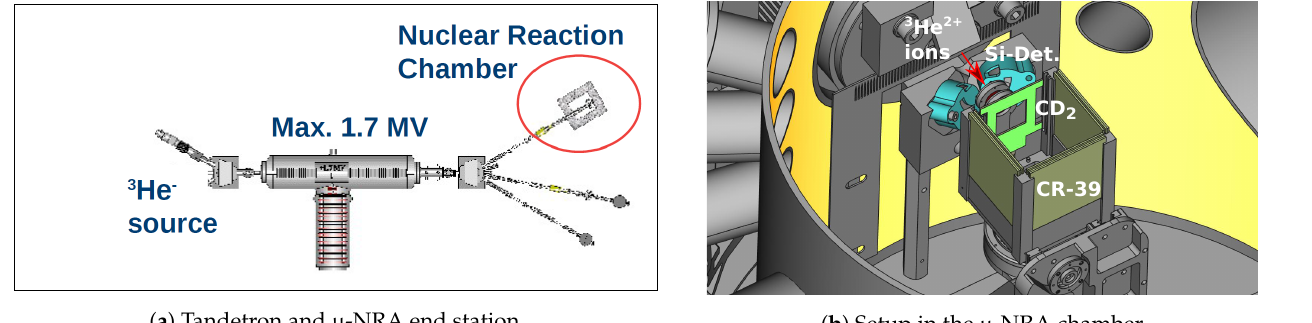
Figure 8. Experimental setup at the Tandetron. ( a ) Schematic diagram of the Tandetron and end stations. ( b ) The polarimeter is installed at the µ -NRA end